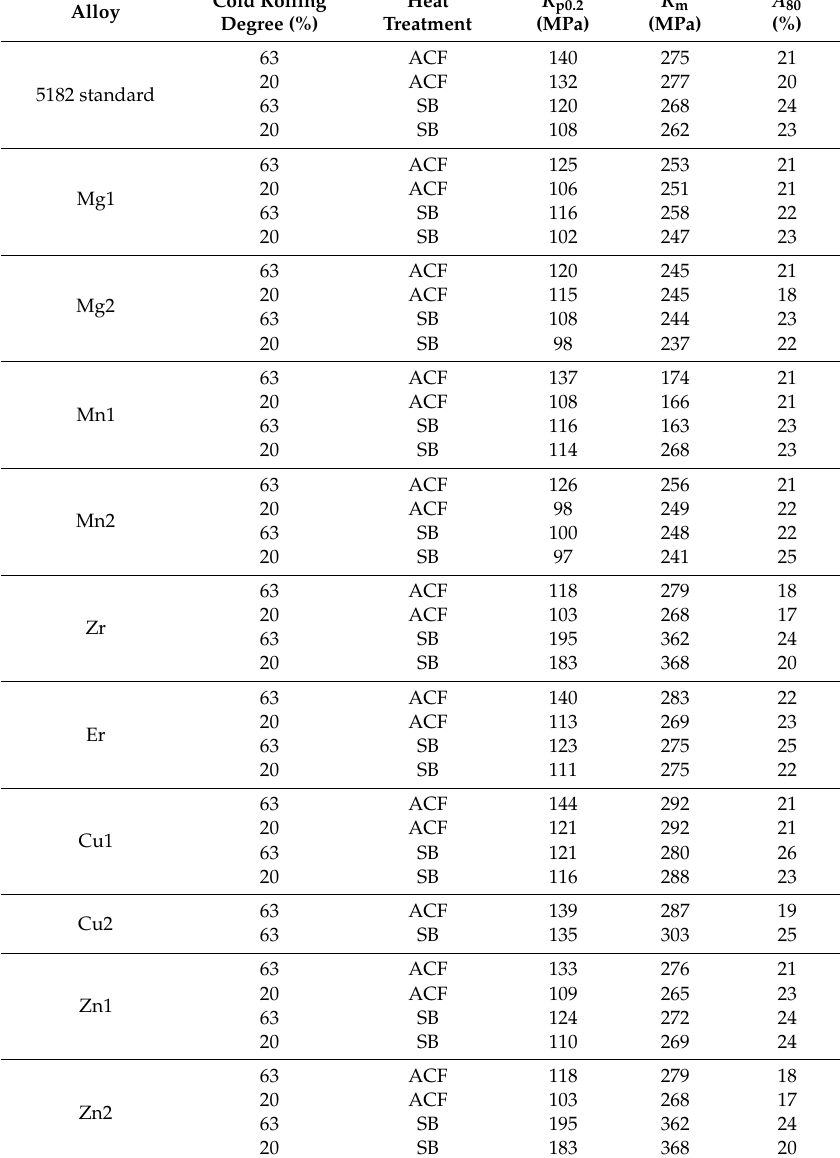
Table A2. Mechanical properties of the tested alloy variations. R p0.2 —0.2% proof stress